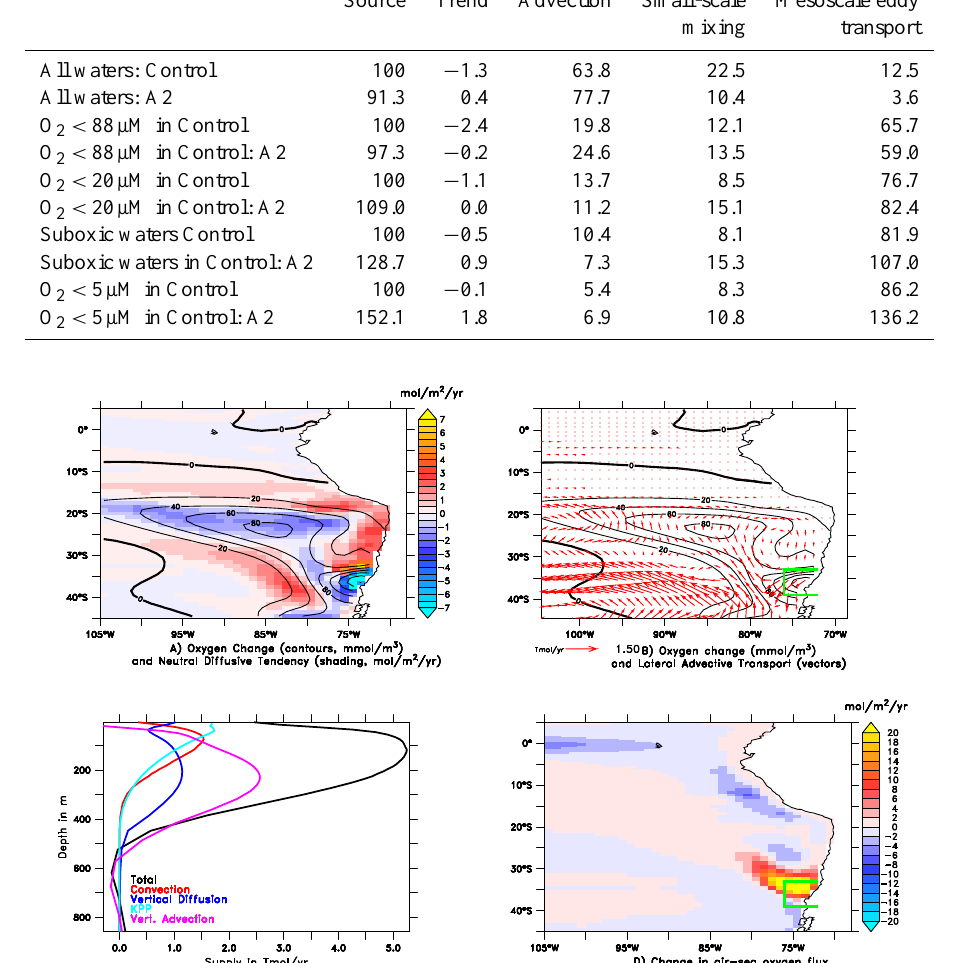
Fig. 4. O 2 changes in the Southeast Pacific from years 2281–2300 in the A2 scenario relative to the corresponding years in the 1860 Control. (A) Contours: oxygen change in µM between the A2 and Control runs averaged over 300–500m. Shading: change in O 2 flux due to mesoscale eddy mixing in molm − 2 yr − 1 . (B) Change in the lateral advective flux of O 2 between 300 and 500m. Green lines outline region between 76 ◦ W and 72 ◦ W 39 ◦ S and 33 ◦ S. (C) Change in downward flux of O 2 due to vertical advective and diffusive processes integrated over 76–72 ◦ W, 39–33 ◦ S. (D) Change in air-sea O 2 flux in mol m − 2 yr − 1 in the Southeast